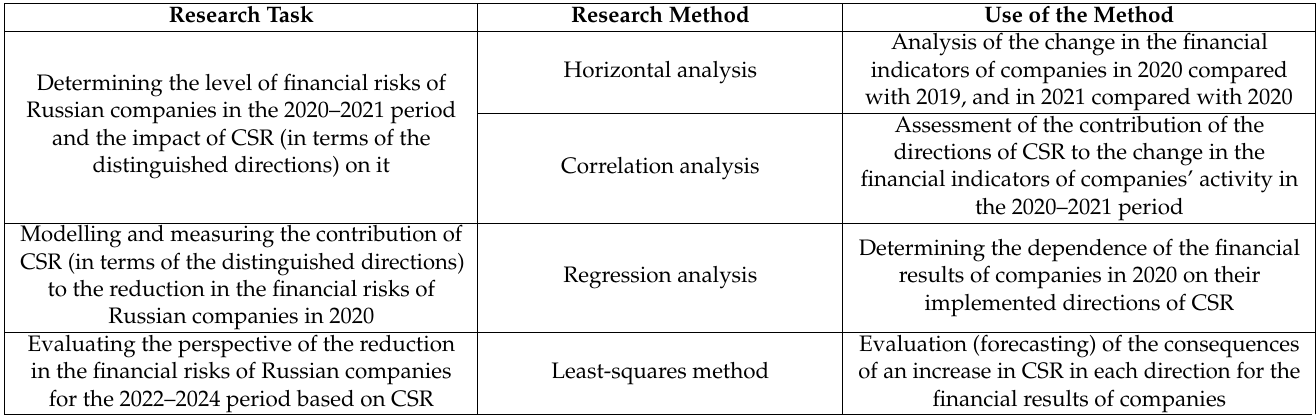
Table 1. The structural and logical scheme of the research.